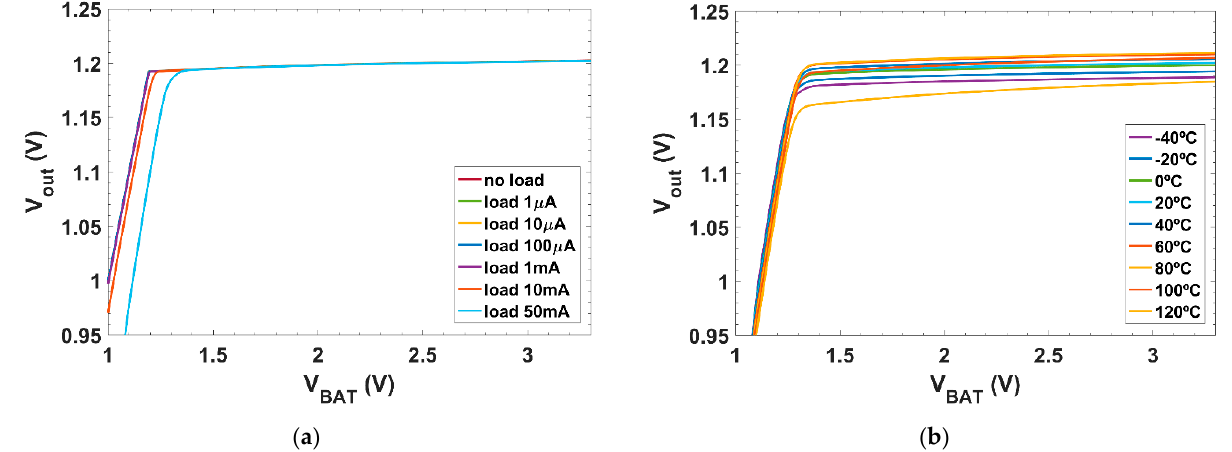
Figure 11. V in − V out characteristic, with: ( a ) different current loads, I Load , and ( b ) different temperatures (at maximum load current, I Load ).